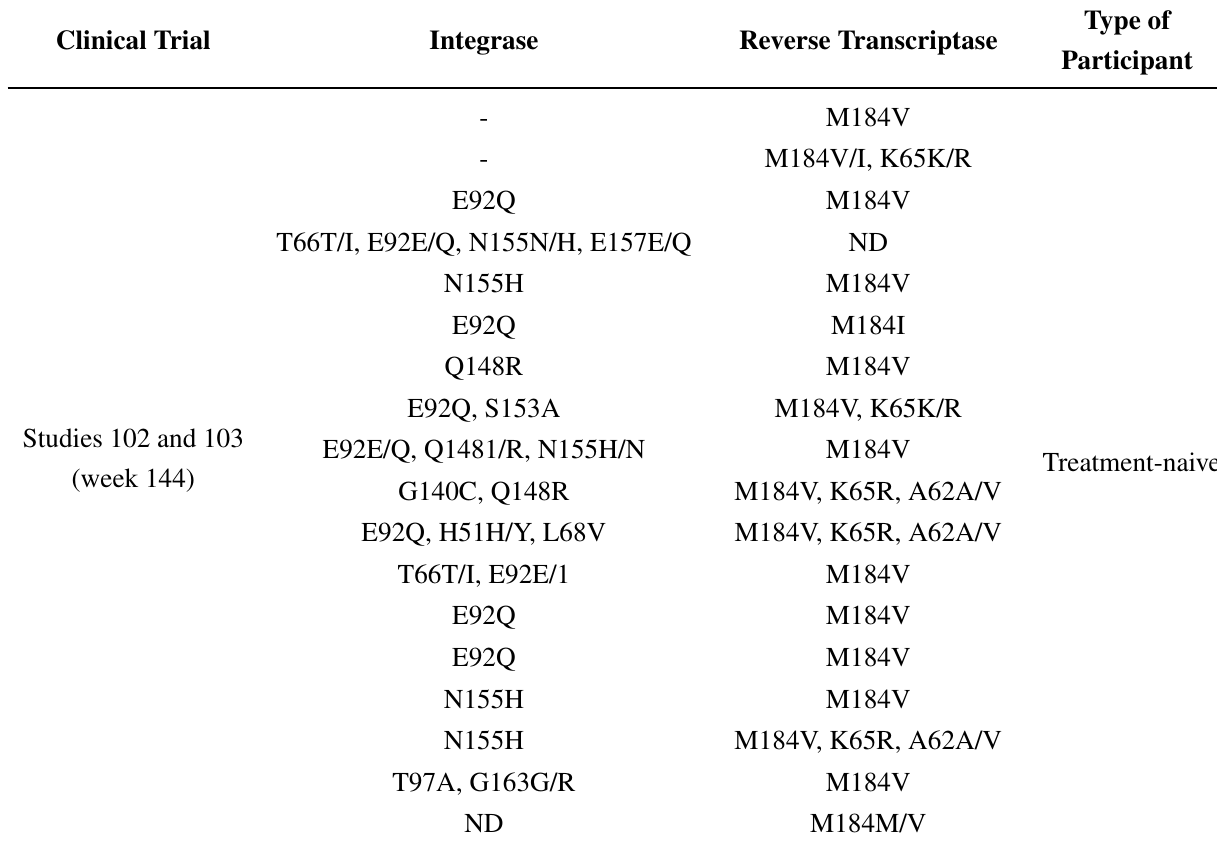
Table 2. Examples of new IN and RT drug resistant mutations emerging after treatment failure with